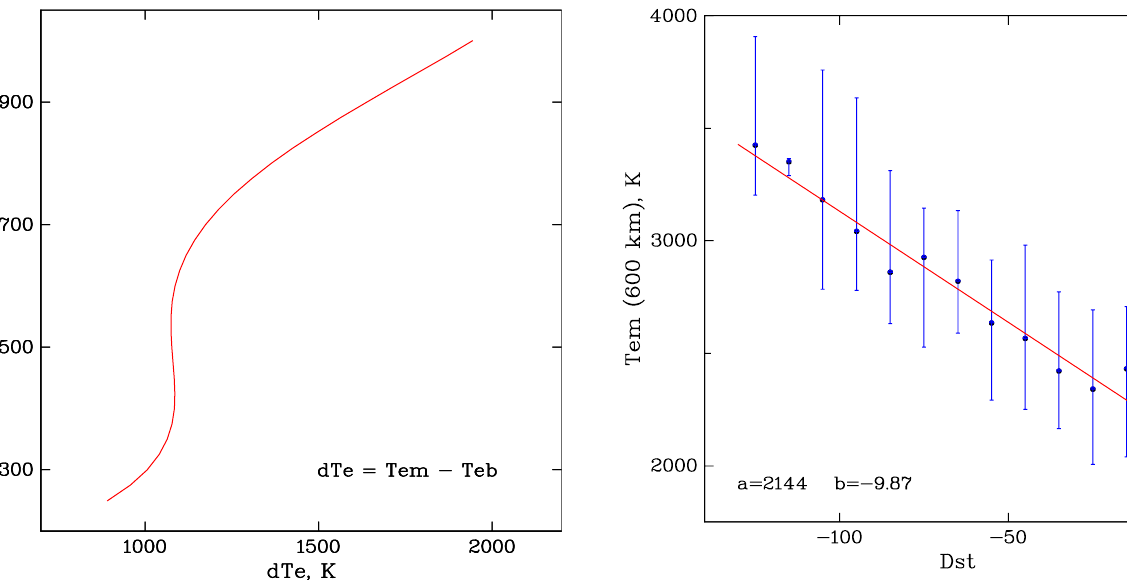
Fig. 8. Magnitude of the subauroral electron temperature enhance- ment as a function of altitude. Plotted is the difference between the temperatures observed at the location of the equatorward boundary and maximum of the heating region. This difference was deter- mined by subtracting Eq. (2) from Eq. (3). Fig. 8. Note the striking increase in dT e above about 700 km altitude.